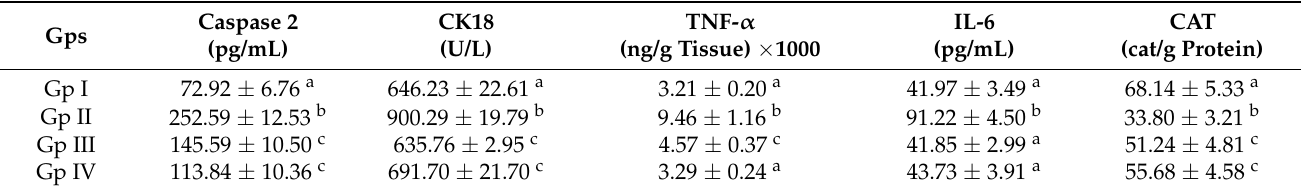
Table 3. Effect of MESC and silymarin on plasma caspase 2, cytokeratin 18 (CK18), and liver TNF- α , interleukin 6 (IL-6), and catalase (CAT) in experimental